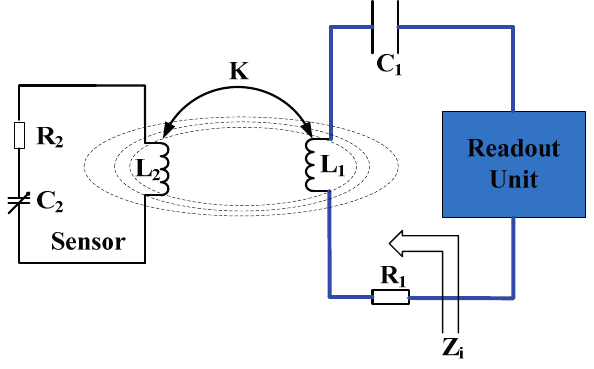
Figure 2. Schematic view of a wireless inductance coupling sensor